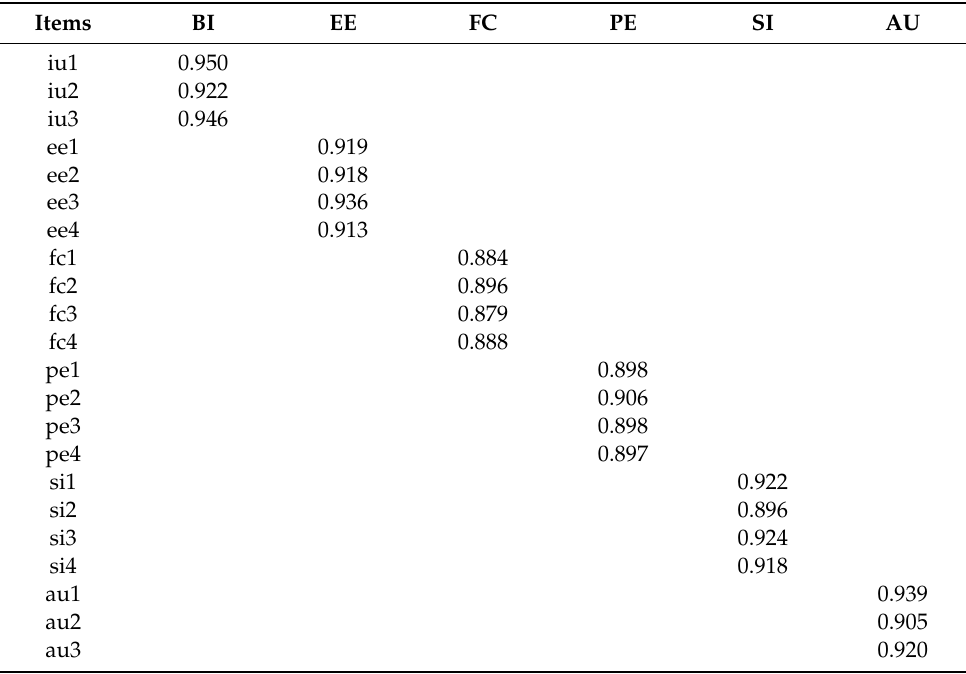
Table 2. Confirmatory factor analysis using